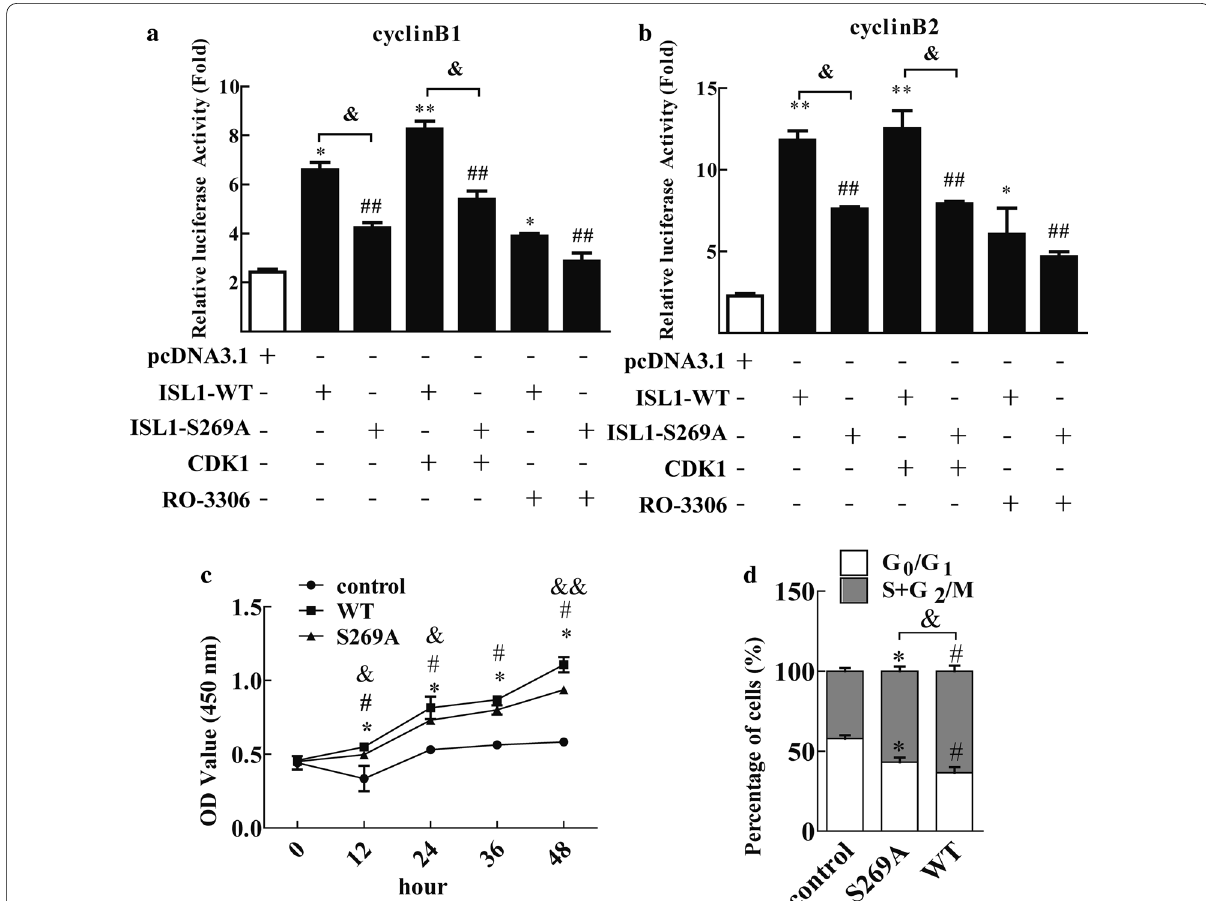
Fig. 5 Phosphorylation Ser 269 of ISL1 increases transactivation potency. a , b Effect of CDK1 activity on the transcriptional activity of wild-type ISL1 or S269A ISL1. Transcriptional activity of wild-type ISL1 and S269A ISL1 on cyclinB1-luc and cyclinB2-luc determined by luciferase reporter assay in MKN28 cells. c Cell proliferation was studied by CCK-8 analysis of MKN28 cells transfected with plasmids encoding control vector and wild-type ISL1 or ISL1-S269A. d Cell cycle distributions were analyzed by flow cytometry in MKN28 transfected with plasmids encoding control vector and wild-type ISL1 or ISL1-S269A. The data represent 3 independent experiments, each performed in triplicate. Each bar represents mean SD. (* p < 0.05, WT vs. control, # p < 0.05, S269A vs. control, $ p < 0.05, WT vs. ±